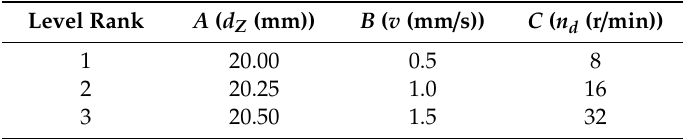
Table 1. Three factors with three